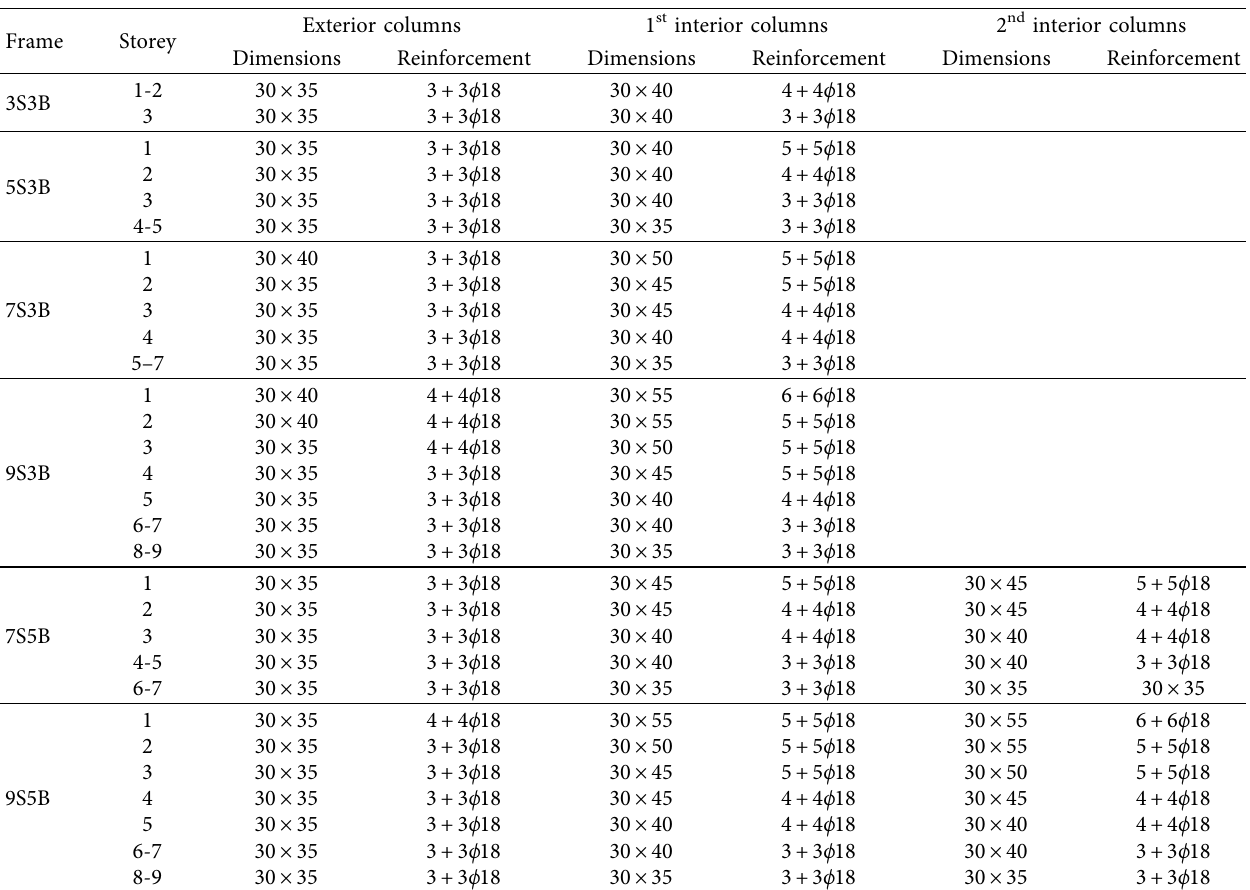
Figure 3: RC moment-resisting frames. Table 1: Column dimensions and reinforcement